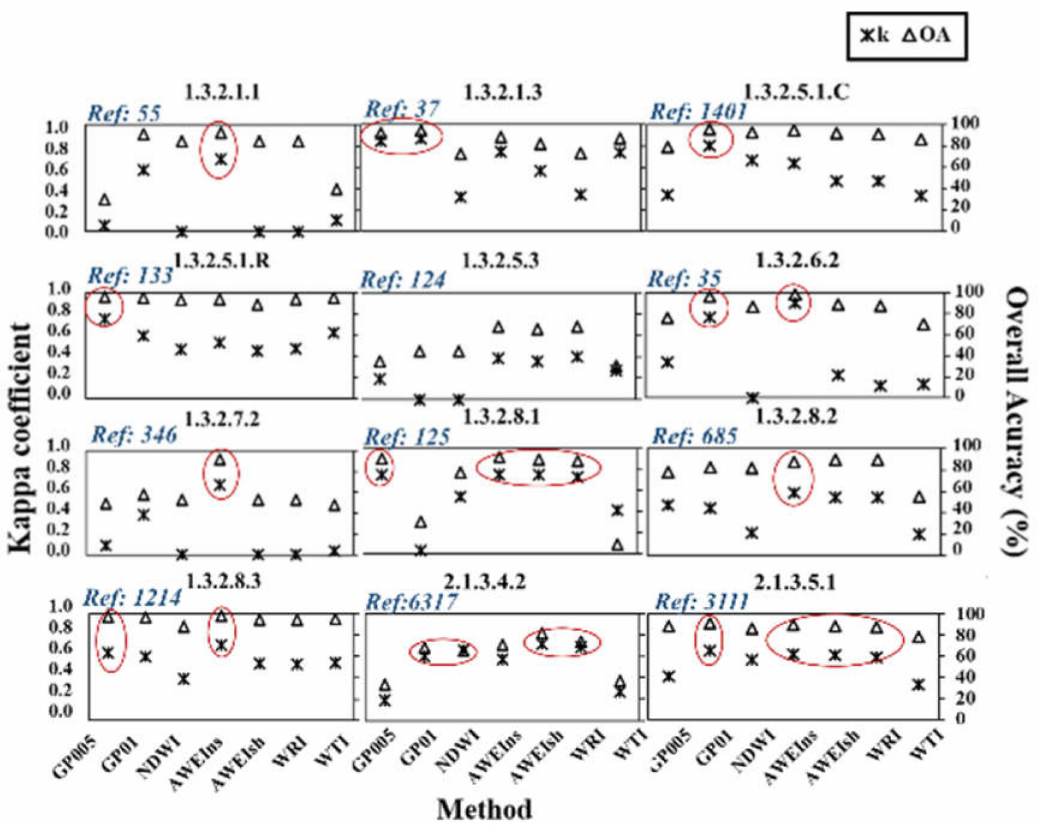
Figure 3. Kappa coefficient (crosses) and overall relative accuracy (triangles) for the different methods tested and the different lake/wetland types as listed in Table 1, for the Landsat-7 imagery. In blue is indicated the number of reference water pixels and the best results for each type are marked in